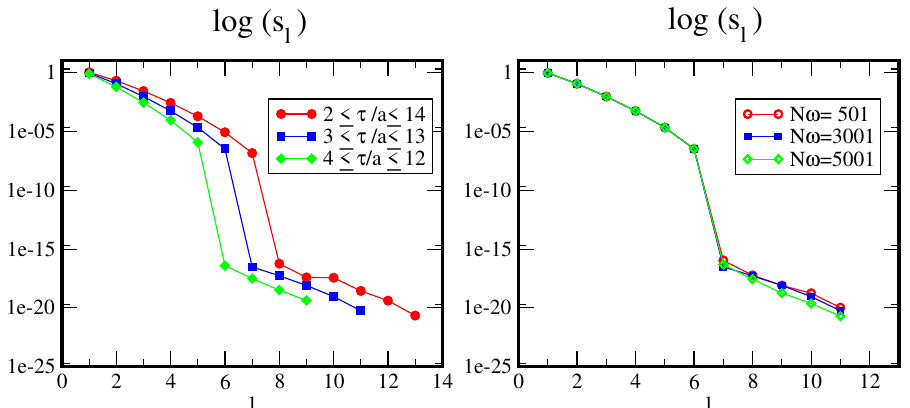
Figure 4 . (cid:28) -regime (left) and N ! (right) dependence of the singular of the kernel matrix. Here, we utilize a! cut = 4 :